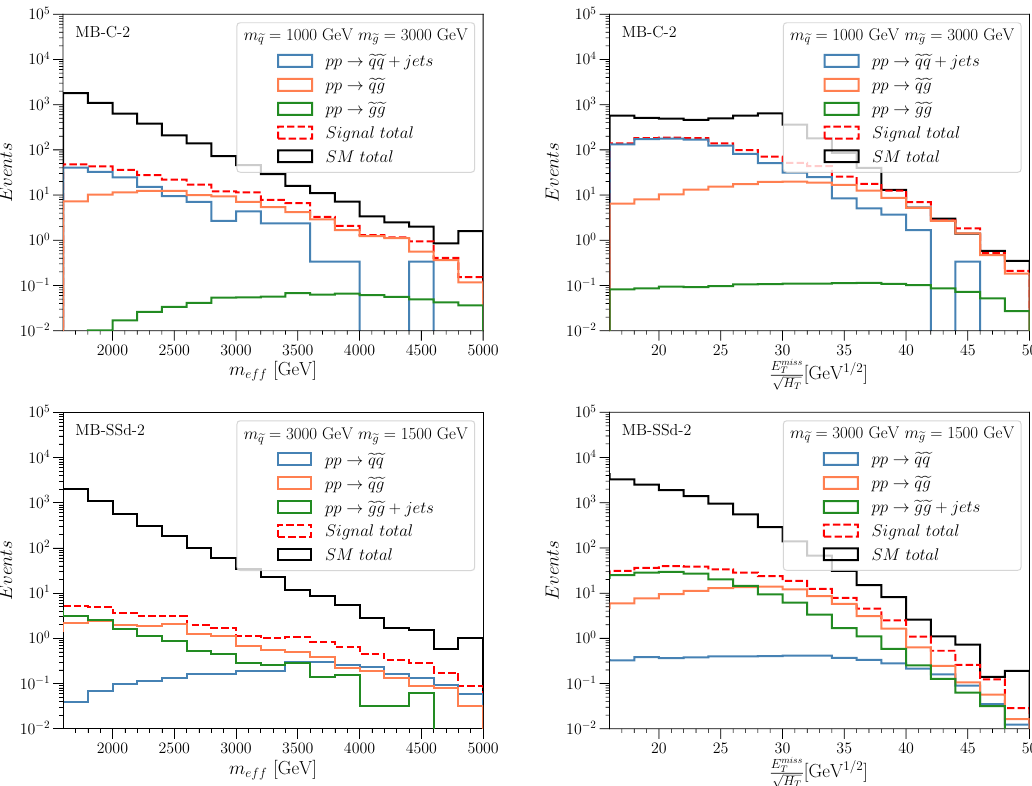
Figure 9 . The m eff (left) and E miss / √ H T (right) distributions after imposing the remaining cuts T in the most sensitive signal region of the ATLAS “jets + E miss ” analysis [10] for the given mass T point. In the upper plots, the masses are taken to be ( m ˜ q , m ˜ g ) = (1 . 0 , 3 . 0) TeV , whereas they are ( m ˜ q , m ˜ g ) = (3 . 0 , 1 . 5) TeV in the lower plots. The SM background distributions are taken from the ATLAS “jets + E miss ” paper T